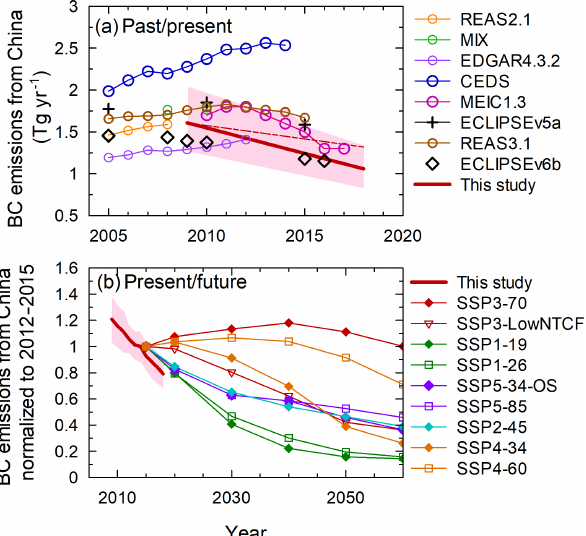
Figure 7. (a) Comparison of estimated black carbon (BC) emis- sions trends (bold red line) for China in past/present periods and compared to various bottom-up emission inventories, as shown in the figure legend. (b) Similar plot showing comparisons with future emission scenarios after normalization from 2012 to 2015, as shown in the figure legend. SSP – Shared Socioeconomic Pathway; NTCF – near-term climate forcer; and OS – overshoot